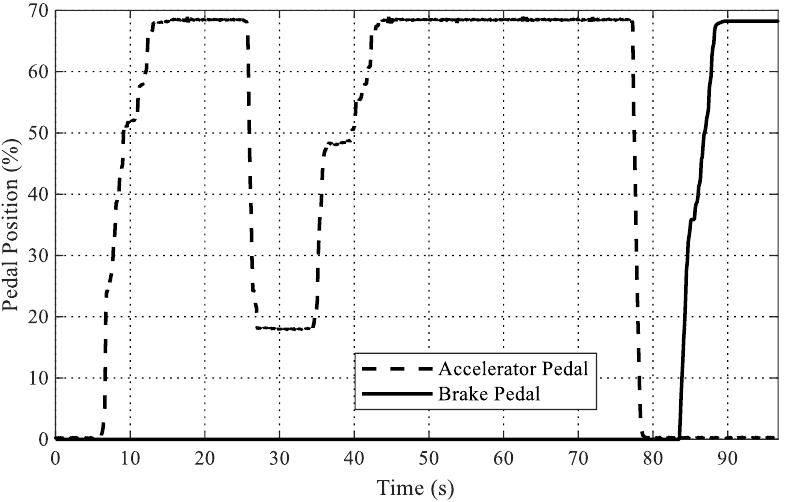
Figure 11. Accelerator and Brake Pedal Position for Scenario 1.